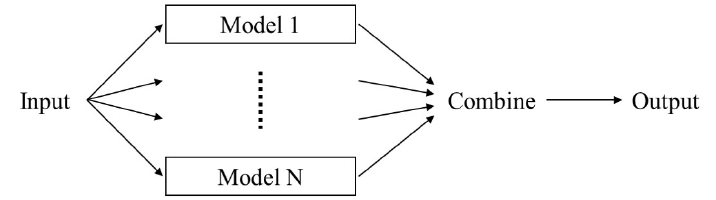
Figure 1. Conceptual diagram of ensemble